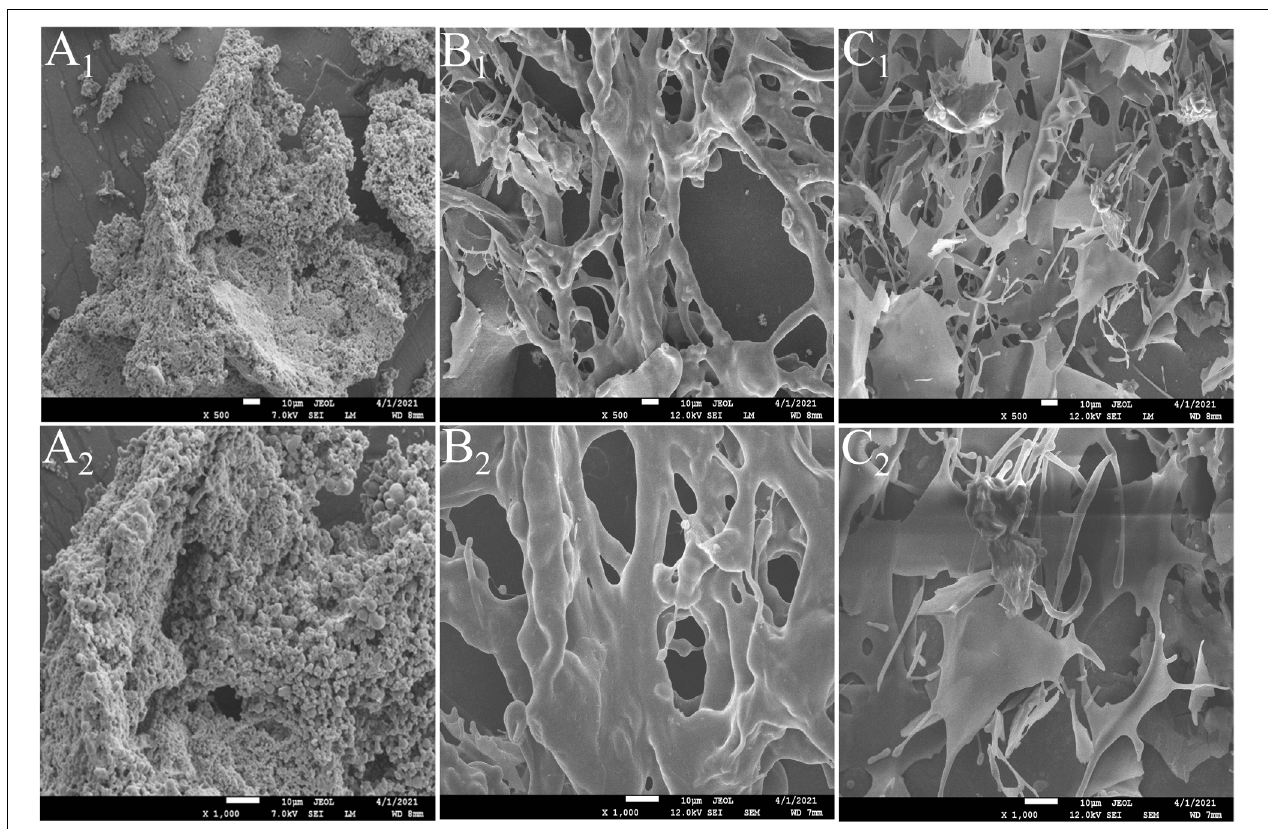
FIGURE 2 | SEM images of CSFP, CSFP1- β , and CSFP2- α at × 500 and × 1,000 magnifications. (A 1 ,A 2 ) CSFP; (B 1 ,B 2 ) CSFP1- β ; and (C 1 ,C 2 ) CSFP2- α